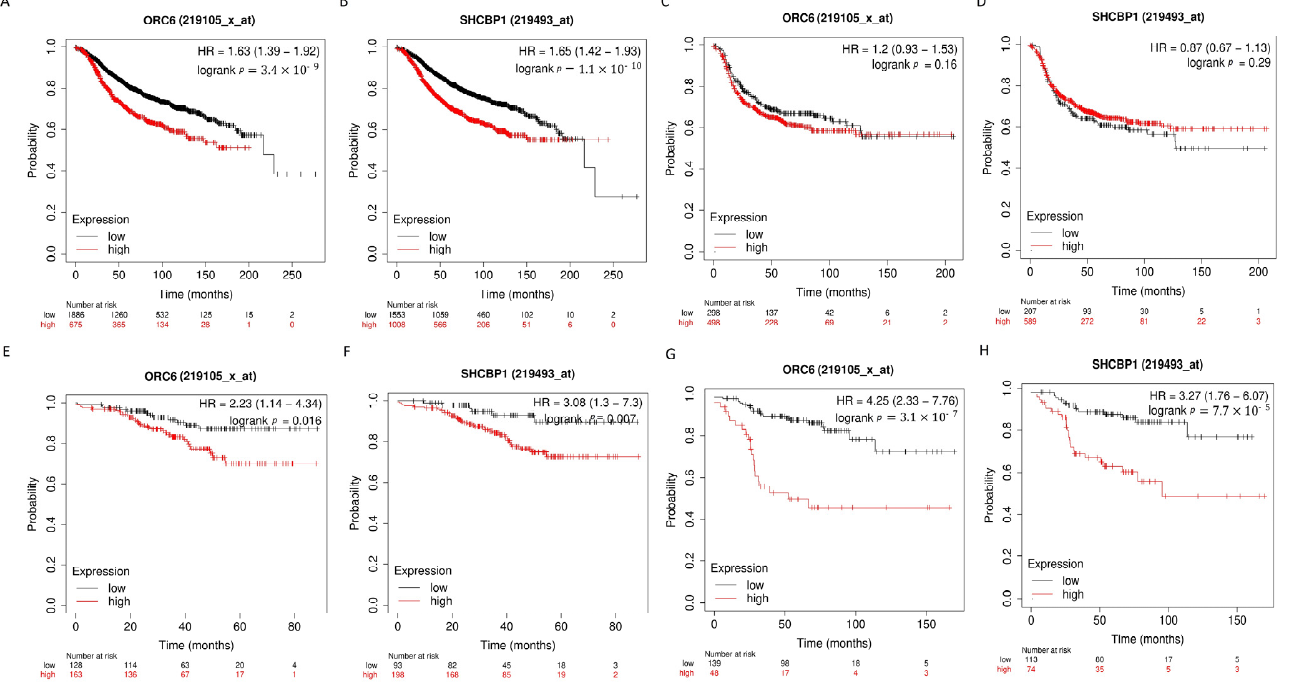
Figure 6. Survival prediction analysis of breast cancer patients. The survival function of progression- free survival (PFS) time is analyzed. ( A ) Kaplan–Meier (K–M) plots for patients with primary ER- positive breast cancer ldiscriminated by ORC6 expression level into ow- and high-risk groups (expres- sion value cut-off = 548). ( B ) K–M plots for patients with primary ER-positive breast cancer discrimi- nated by SHCBP1 expression level into low- and high-risk groups (expression value cut-off = 157). ( C ) K–M plots for patients with primary ER-negative breast cancer discriminated by ORC6 expression level into low- and high-risk groups. ( D ) K–M plots for patients with primary ER-negative breast cancer discriminated by SHCBP1 expression level into low- and high-risk groups. ( E ) K–M plots for patients with primary ER-positive breast cancer discriminated by ORC6 expression level into low- and high-risk groups (expression value cut-off = 373). Cohort treatment: endocrine therapy + neoadjuvant therapy. ( F ) K–M plots for patients with primary ER-positive breast cancer discriminated by SHCBP1 expression level into low- and high-risk groups (expression value cut-off = 106). Cohort treatment: endocrine therapy + neoadjuvant therapy. ( G ) K–M plots for patients with primary ER-positive breast cancer discriminated by ORC6 expression level into low- and high-risk groups. Cohort treatment: en- docrine therapy + adjuvant therapy (expression value cut-off = 692). ( H ) K–M plots for patients with primary ER-positive breast cancer discriminated by ORC6 expression level into low- and high-risk groups (expression value cut-off = 205). Cohort treatment: endocrine therapy + adjuvant therapy. Higher risk (red color line) is associated with higher expression